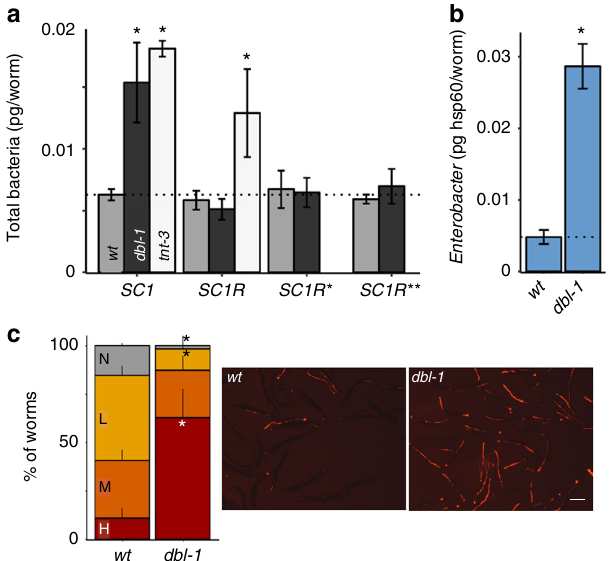
Fig. 3 dbl-1 disruption speci fi cally affects Enterobacter species. a Microbiota size in worms of the designated strains raised on different versions of the SC1 synthetic community — without Pseudomonas and most of the Enterobacteriaceae isolates (SC1R), without most Enterobacteriaceae (SC1R*), or without Enterobacter isolates (SC1R**). Average ± SD of two independent populations ( n = 30/experiment); * p < 0.05 compared with wild-type, t - test. b Measurements of the Enterbacter load (assessed with calibrated qPCR using Enterobacter -speci fi c primers) in wild-type animals (N2) and dbl-1 mutants raised on SC1. Average ± SD of two independent populations ( n = 30 worms per population). * p < 0.05 compared with N2, t- test. c Representative images and quanti fi cation of worm colonization by tdTomato-expressing Enterobacter cloacae CEent1 . H high, M moderate, L light, N none. Averages ± SD of two independent experiments ( n = 62 –